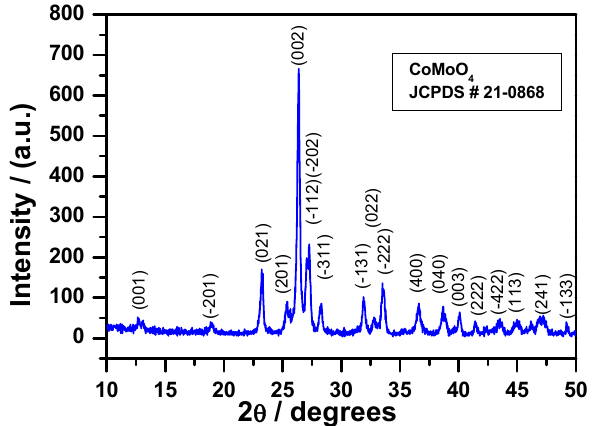
Figure 3. XRD pattern of the β -CoMoO 4 nanoparticle powder obtained after calcination of the oxalate precursor at 550 °C.